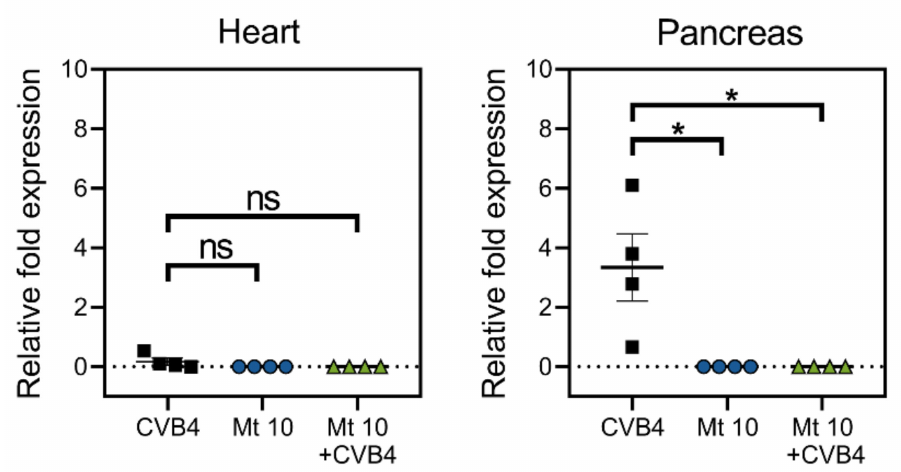
Figure 6. Vaccinated mice challenged with CVB4 did not reveal detection of viral nucleic acids. Groups of mice were given saline or were vaccinated with Mt10 virus, and 14 days later, challenged with or without CVB4. Hearts and pancreata were collected three weeks post-challenge, total RNA was extracted, and viral RNA was estimated by qPCR targeting VP1 sequences. After normalizing the expression levels of viral RNA relative to GAPDH, 2 − ( ∆∆ Ct) values were calculated. Mean ± SEM values representing four samples per group, each containing n = 3–5 mice, are shown. Mann–Whitney test was used to determine significance between groups. * p ≤ 0.05; ns—not